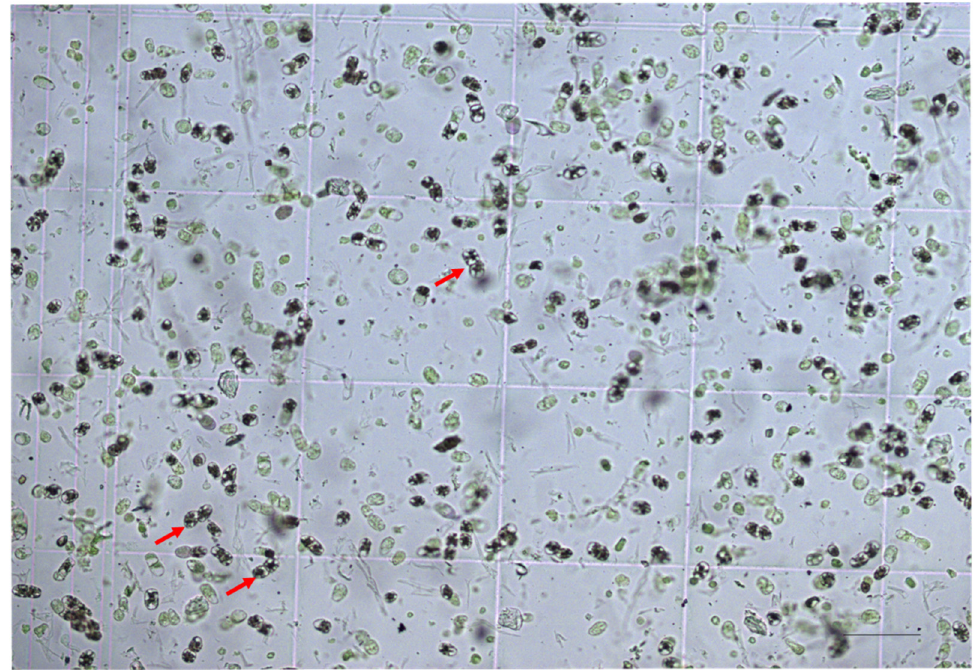
Figure 6. Microscopic observation of protoplasts culture by hemocytometer. The red and brown cells were normal, and the green fragments were dead. The red arrows denoted the representative division cells (Scale bars = 100 µm). Table 1. Survival rates and division rates of protoplasts incubated at different temperatures.